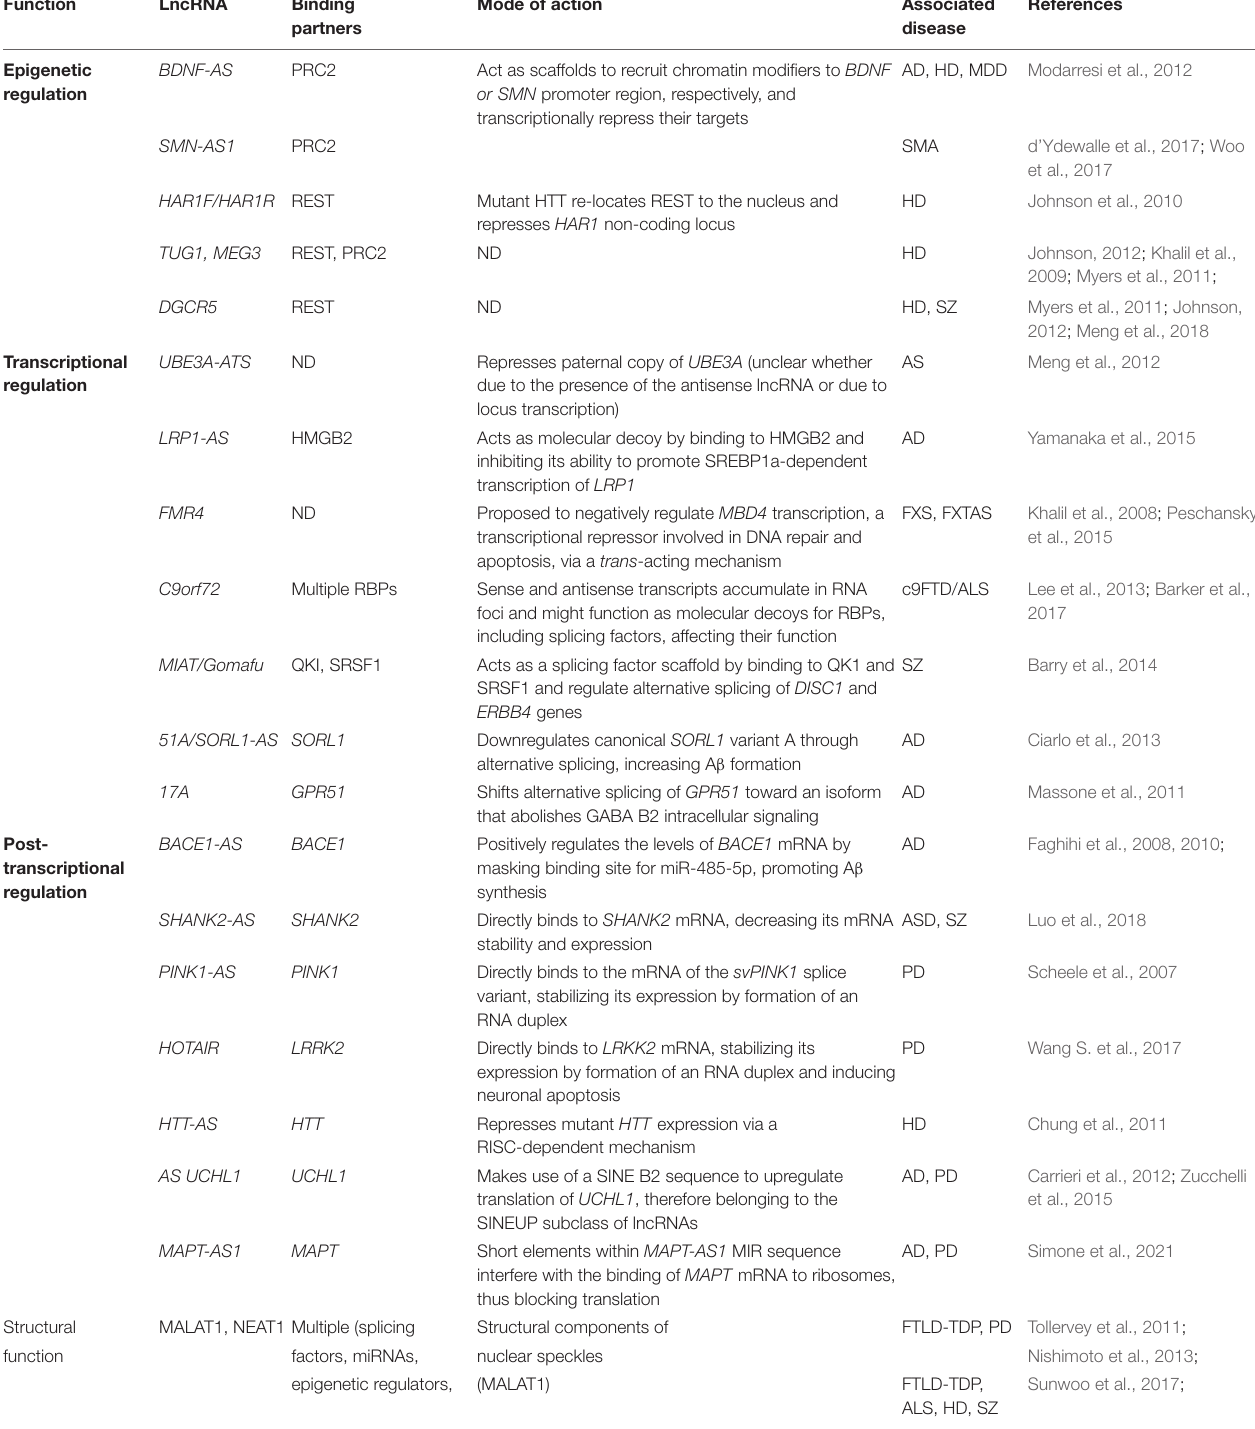
TABLE 1 | LncRNA regulatory mechanisms and their contribution to CNS